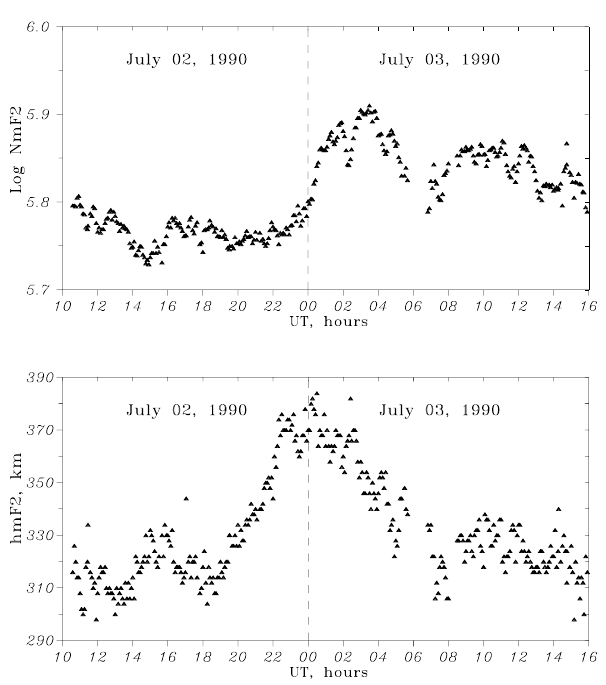
Fig. 1. Observed with EISCAT diurnal variations of NmF2 and hm F2 on 02/03 July 1990.